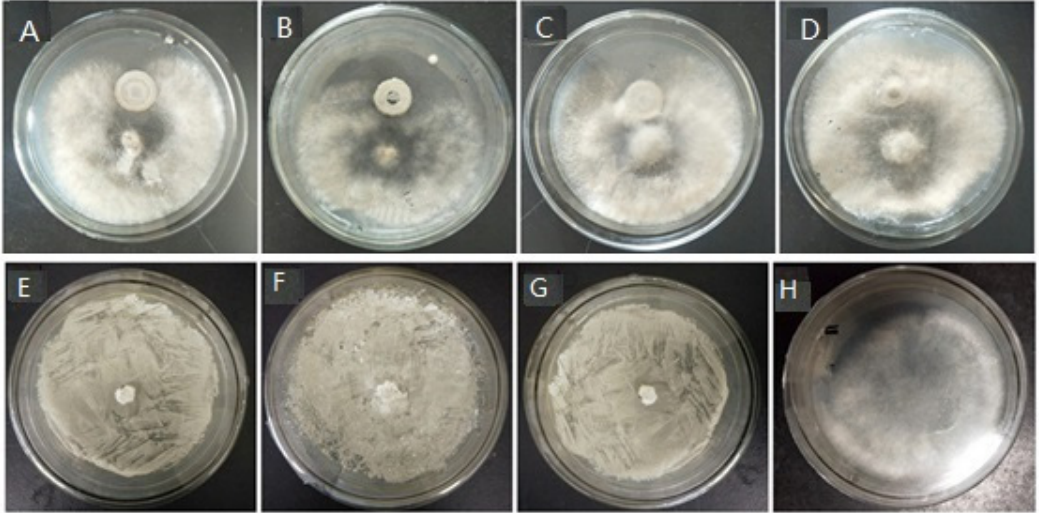
Figure 1. Antifungal activity of three biocontrol yeast strains against Botrytis cinerea . ( A – H ) represent Ca63, Ca64, Yett 1006, and control, respectively. The upper row shows the results of filter paper method, and the lower row shows the results of plate coating method.